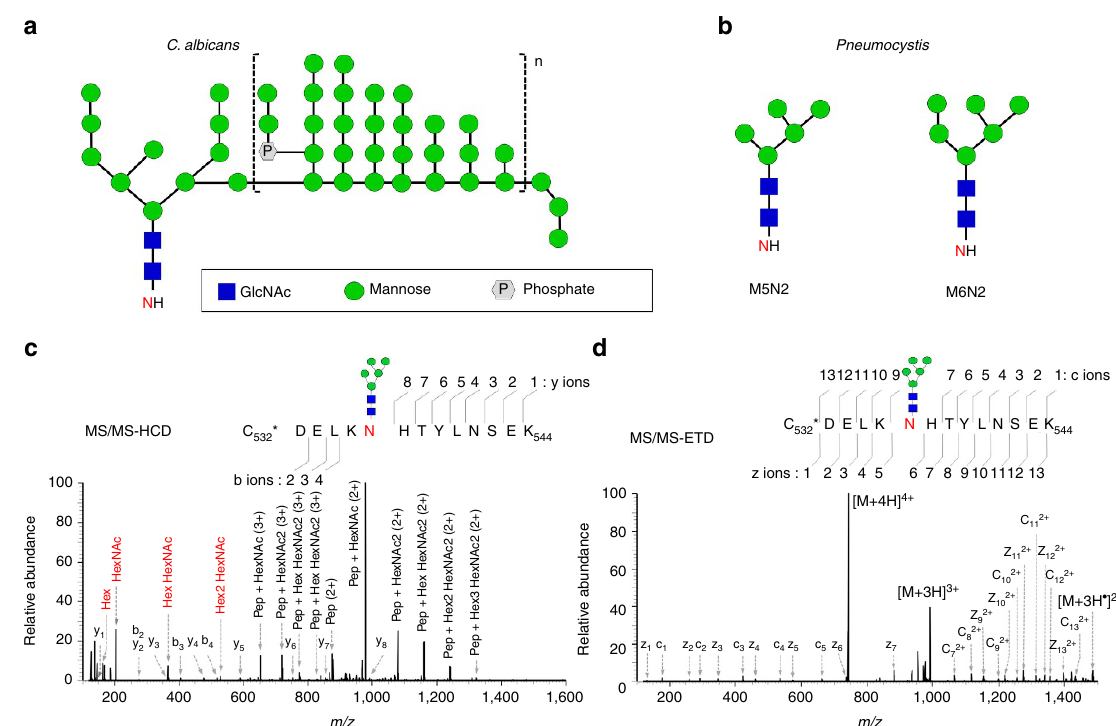
Figure 7 | Lack of hyper-mannose (mannan) glycosylation in Pneumocystis . ( a ) Diagram of N-linked mannan structure in C. albicans , based on ref. 43. ( b ) Diagram of N-linked glycans in Pneumocystis , which lack the a -1,6-linked mannose backbone as well as a -1, 2- and a -1,3- linked mannose outer chains seen in C. albicans (square brackets). ( c , d ) Representative results of tandem mass spectrometry (MS/MS)-higher energy collisional dissociation (HCD) and electron transfer dissociation (ETD) analysis of an N-linked glycopeptide carrying Hexose5 HexNAc2 (M5N2) from one Msg isoform (T552_03736) in P. carinii . ( c ) MS/MS-HCD spectrum of glycopeptides showing the detection of glycan oxonium ions in the low mass region at m/z 163.0603, 204.0868, 366.1398 and 528.1929 (indicated in red font). A series of fragment ions dues to neutral loss of the glycan moiety were observed as the main fragment ions in the HCD spectrum. Trace amounts of y-type and b-type peptide fragment ions were detected, confirming the sequence of the peptide backbone. ( d ) MS/MS-ETD spectra of peptide fragment ions with minimal neutral loss of glycan moiety. All expected peptide c-type and z-type fragment ions were detected except c8 fragment ion, confirming the peptide sequence with high confidence, as well as the site and mass of the glycosylation